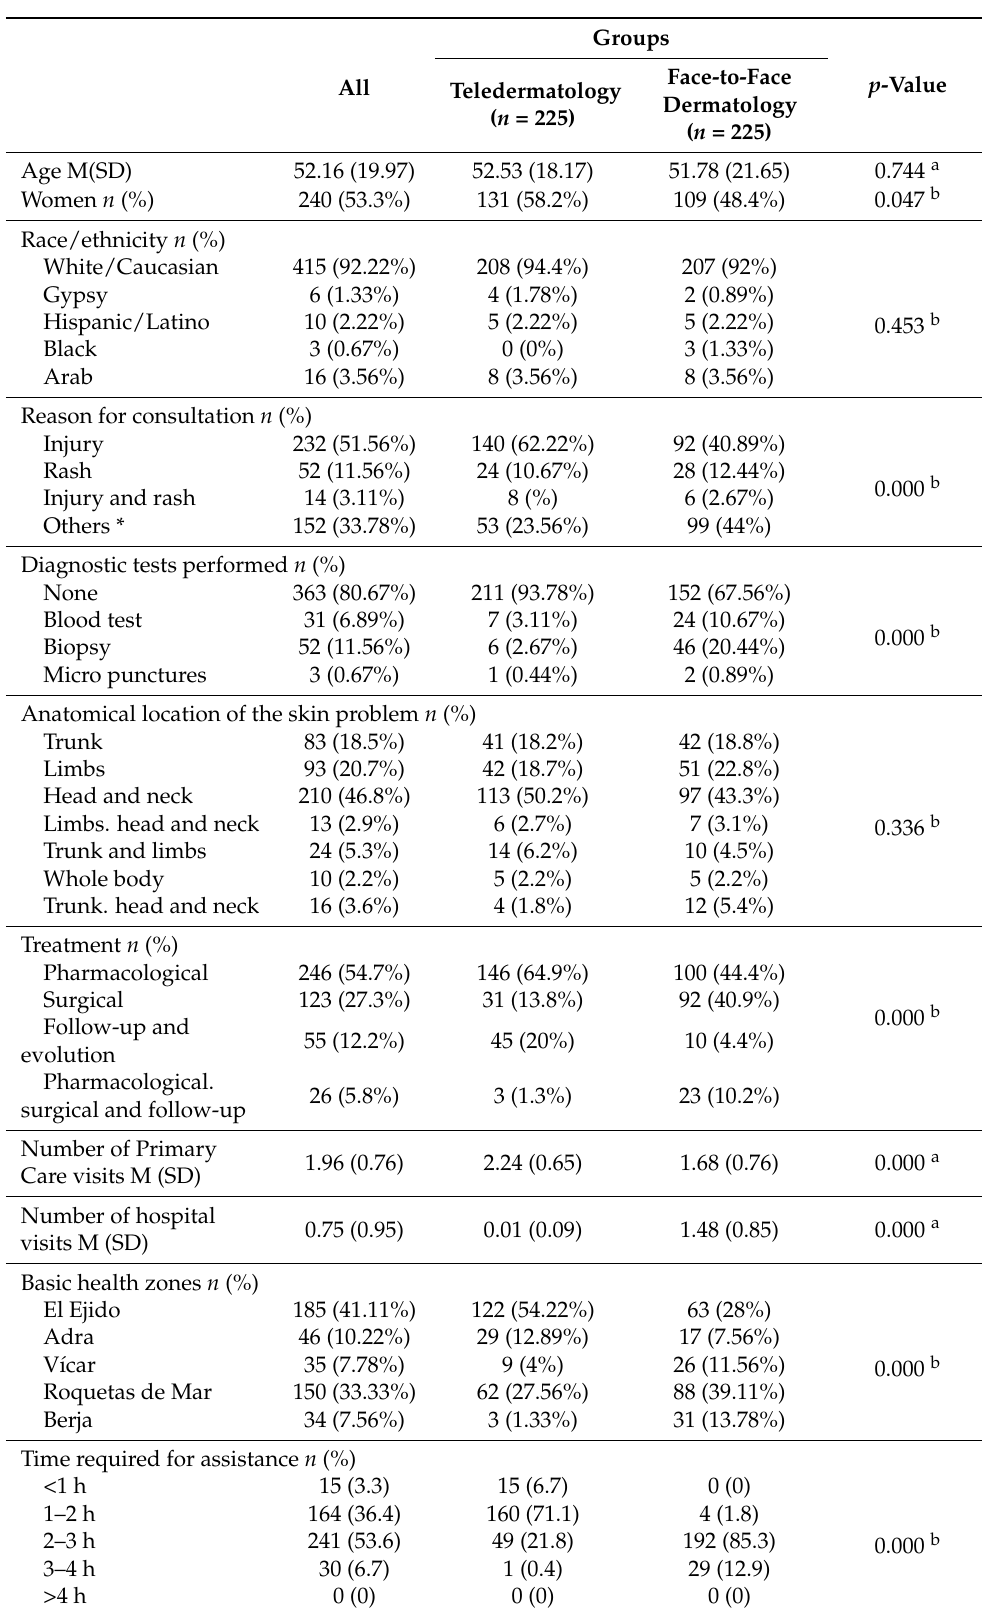
Table 2. Selected patient baseline